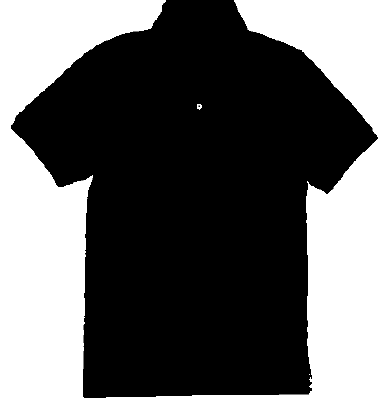
Figure 6. Partition threshold result.